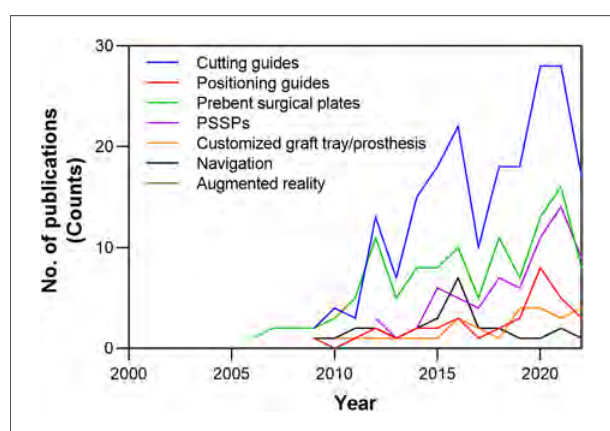
FIGURE 9 The evolution of hardware and devices used in CAMR, according to the number of academic publications over time in the